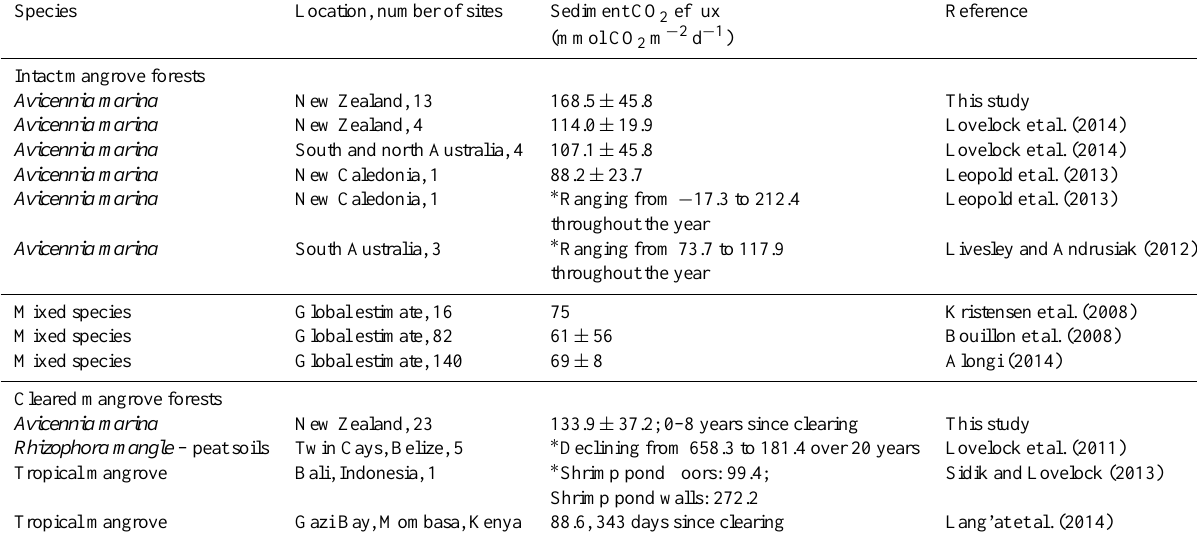
Table 2. Comparison of mean estimates of sediment CO 2 efflux in intact and cleared mangrove forests. Values are means ±